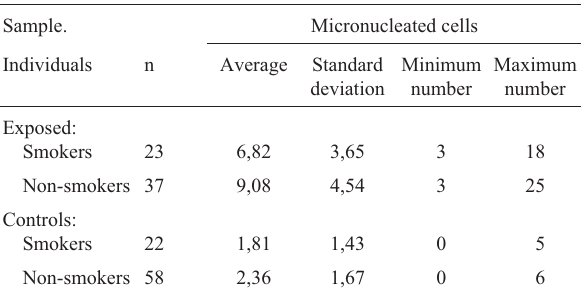
Table III - Average numbers of micronucleated cells (in 3000 cells analyzedperindividual)ofthegroupofindividualsexposedtobyproducts of petrol and lead, and of controls, grouped by smoking habit. Sample.